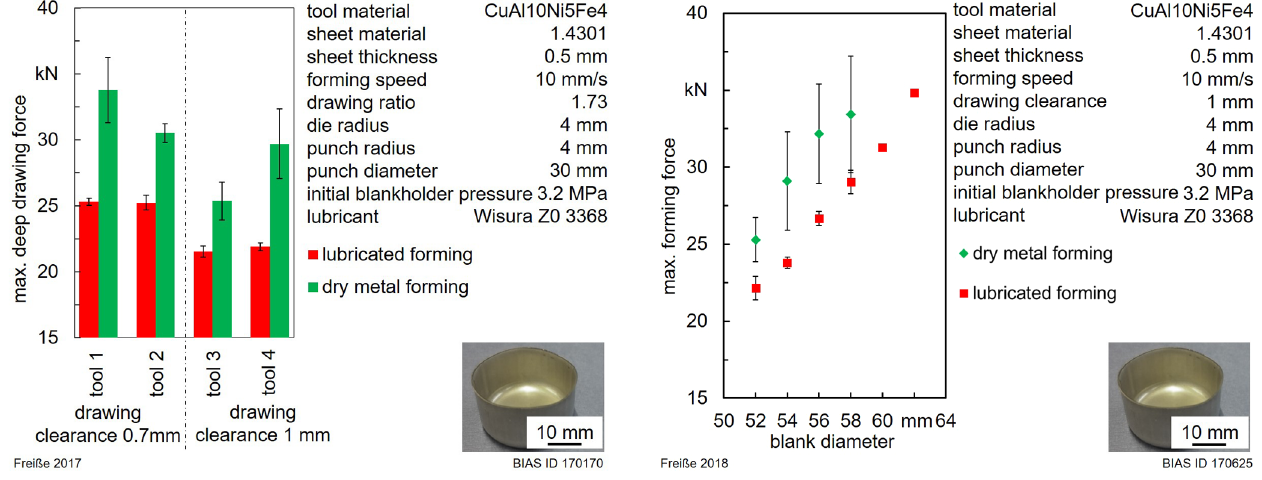
Fig. 17. Maximum deep drawing forces using milled bronze tool under variation of the drawing clearance.